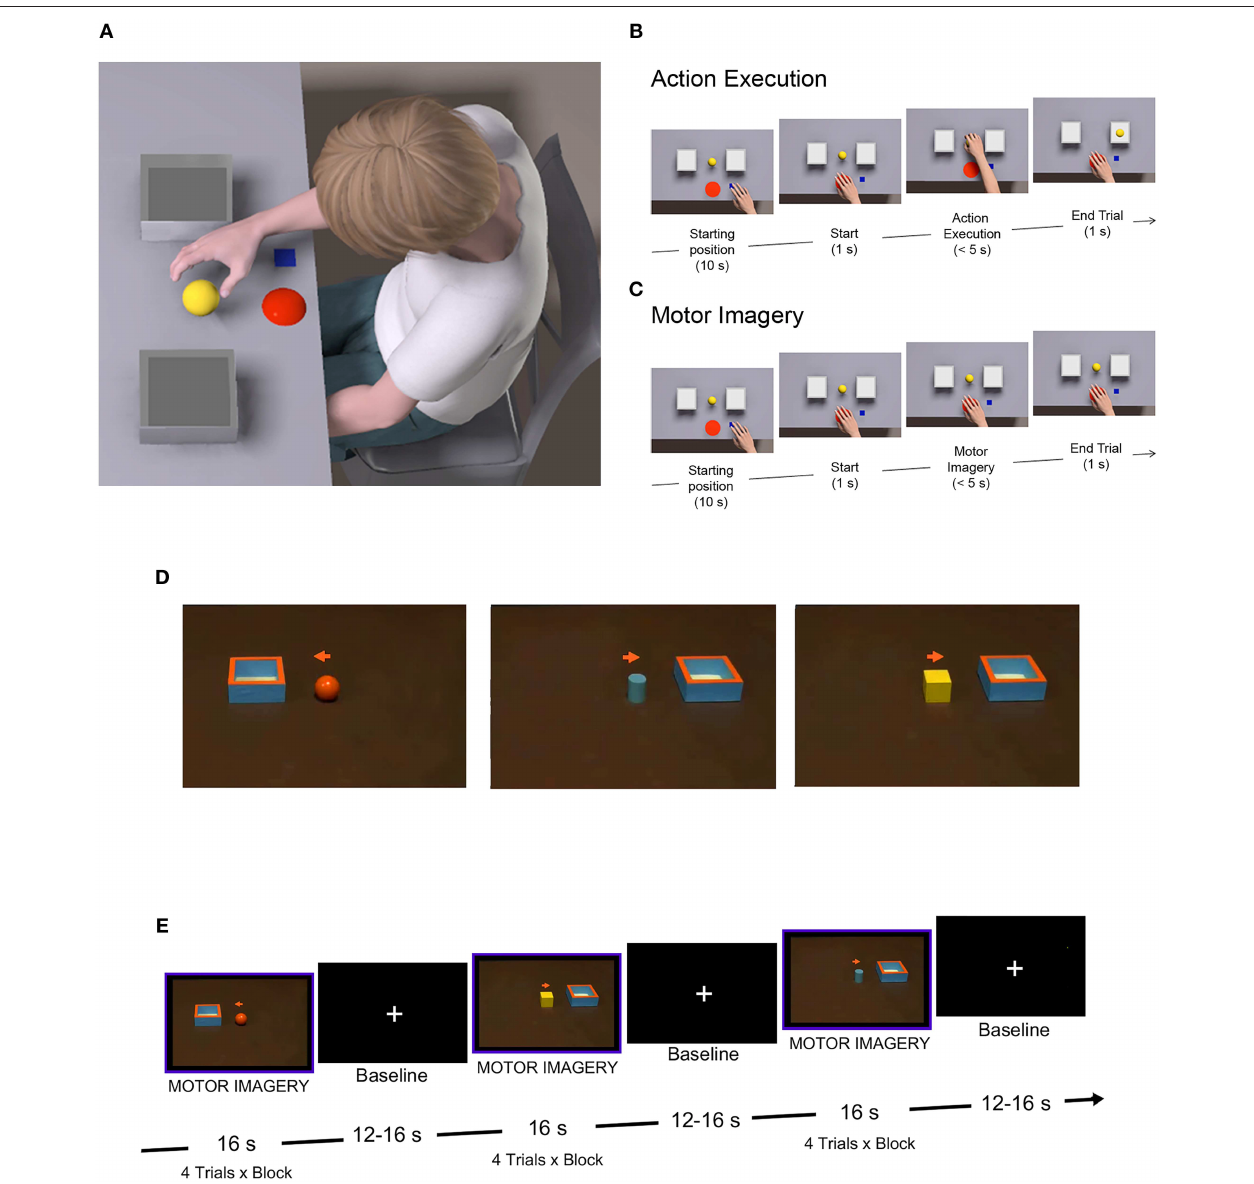
FIGURE 1 | Behavioral and fMRI paradigms. (A) Experimental setting for the mental chronometry task. (B) Action execution trial, consisting in reaching/grasping the object, placed at one of the three different distances with the preferred hand or the non-preferred one in different trials, and placing it into a container. (C) Motor imagery trial, requiring participants to imagine performing the same action as in (B) , from a first-person perspective. (D) Stimuli used during the fMRI task, showing an object and a box on a table. Simultaneously, participants had to imagine themselves grasping the object with the non-preferred hand and placing it into the box. (E) fMRI block design, alternating task and rest conditions, with a total number of eight blocks, constituted by four trials per block.